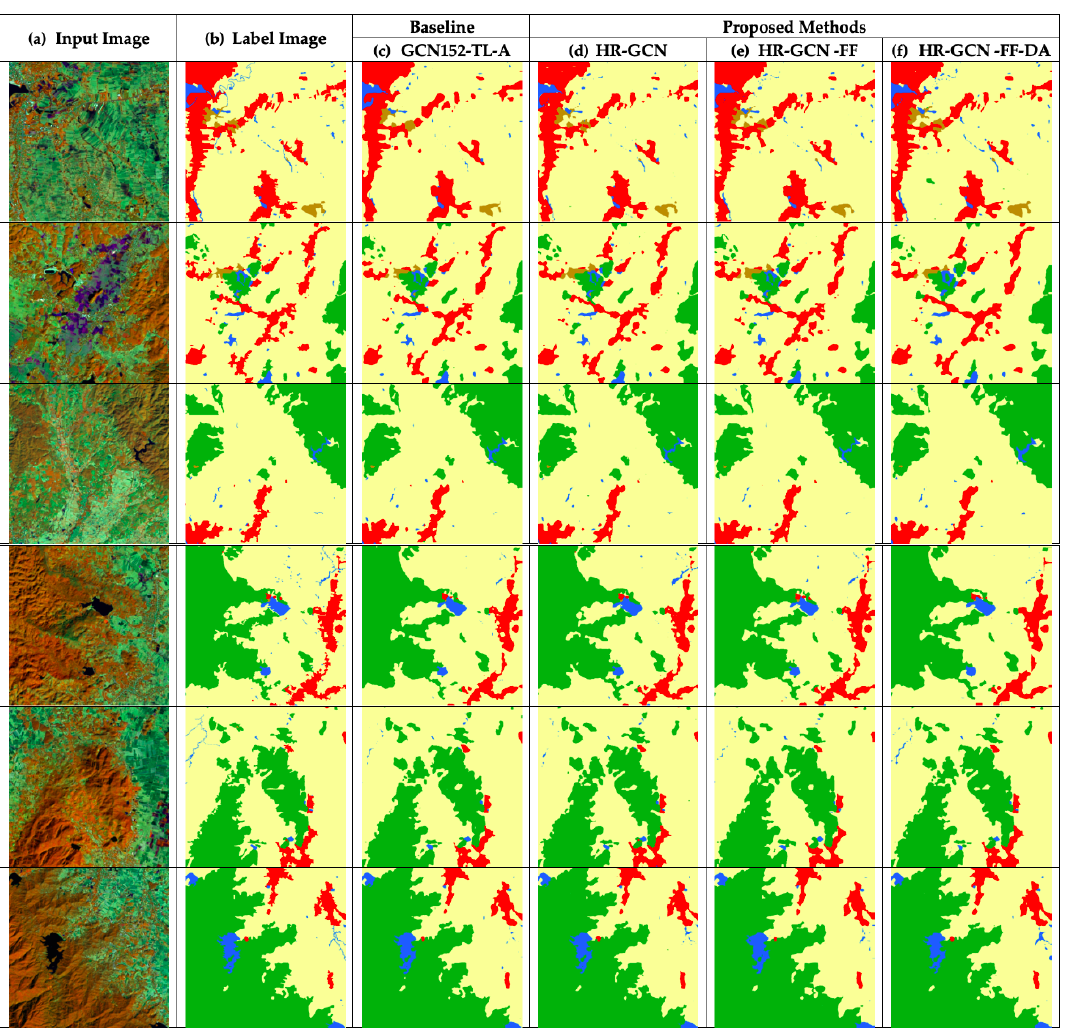
Figure 15. Comparisons between “HR-GCN-FF-DA” and beyond baseline methods on the Landsat-8w5c corpus testing set.